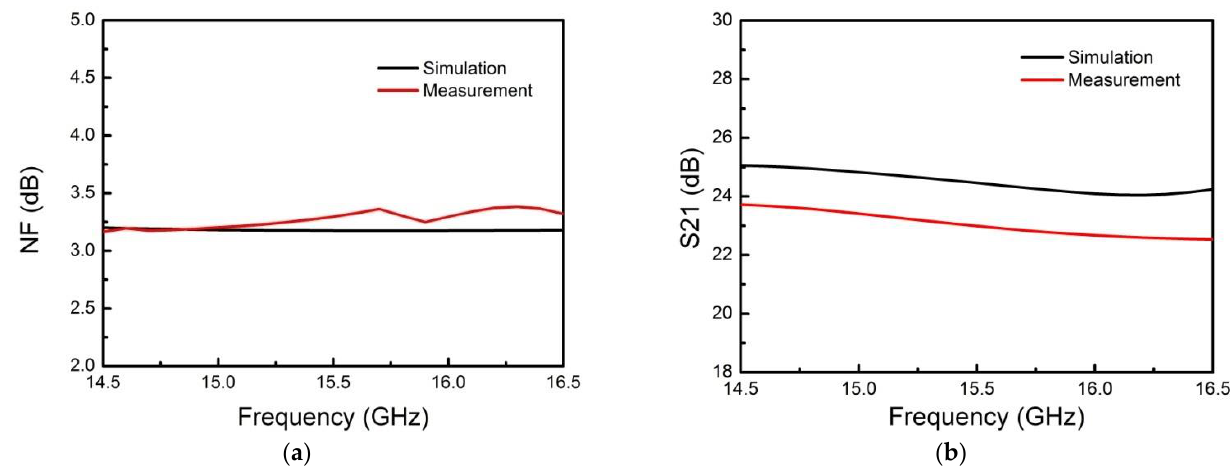
Figure 9. Comparison of simulation and measurement of the proposed Ku-band SIP in receiving state. ( a ) Simulated and measured noise figure curve; ( b ) Simulated and measured linear gain curve.